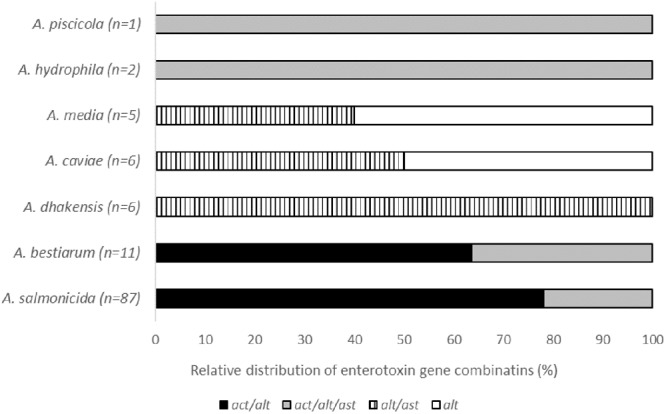
Relative distribution of the combinations of the enterotoxin genes act, alt, and ast in the different groups of Aeromonas spp.